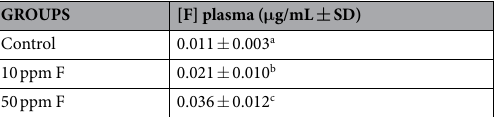
Table 1. Average Plasma fluoride concentration ( μ g/mL ± SD) in rats exposed or not to F chronically, through the drinking water for 30 days. Animal groups: Control (deionized water–0 ppm F), 10 ppm F, and 50 ppm de F. * Different letter indicated significant difference among the groups (ANOVA after log transformation and Tukey’s test (p < 0.001)). n =